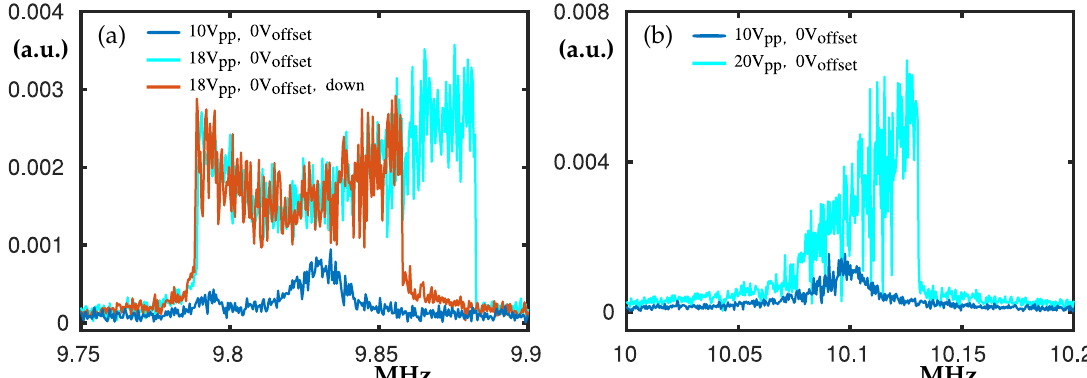
Figure 5. Experimental frequency swipes centred at about 9.8 MHz in panel ( a ) and 10.1 MHz in panel ( b ). In panel ( a ) V of f = 0, where the blue curve denote swipe up for V pp = 10 V and the cyan and red curves denote swipe up and down for V pp = 18 V. In panel ( b ) V of f = 0 V and the blue and cyan curves denote swipe-up for V pp = 10 V and V pp = 20 V, respectively. The peak at about 10.1 MHz appears at twice the frequency of the peak shown in Figure 3b.